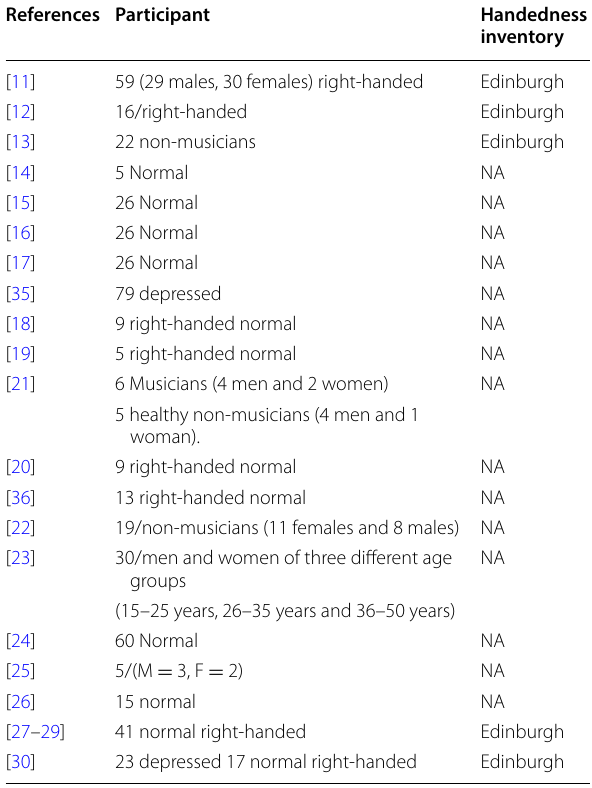
Table 2 Analysis on the basis of participant and